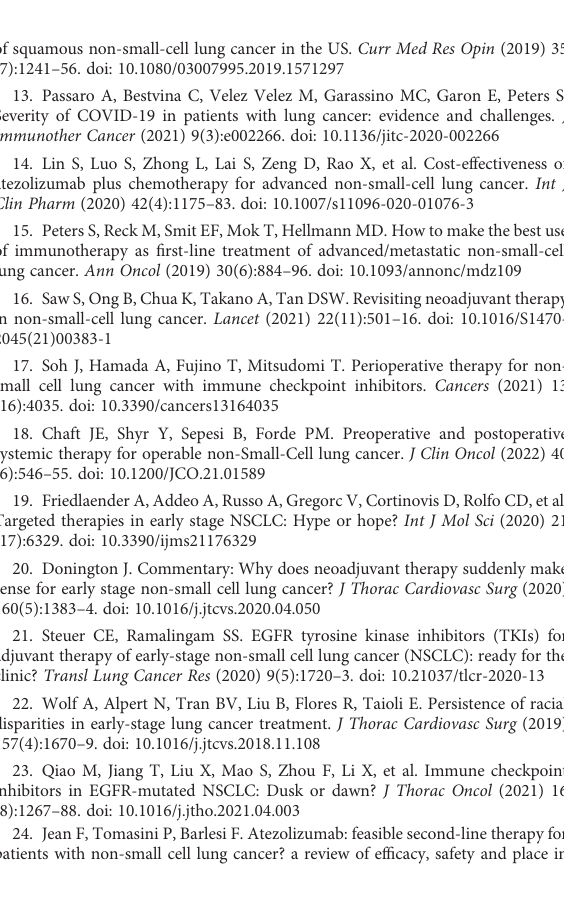
SUPPLEMENTARY FIGURE 1 Tornadodiagramindicatingthemostin fl uentialparameterin (A) PD-L1TC ≥ 1% stage II – IIIA group (SP263), (B) All stage II – IIIA, (C) Intention-to-treat group (stage IB – IIIA) when PAP is applicable. cA, cost per cycle of atezolizumab treatment; uPfs, health utility of disease-free survival status; dis, discount rate; cBsc, cost per cycle of best supportive care; cSt, cost